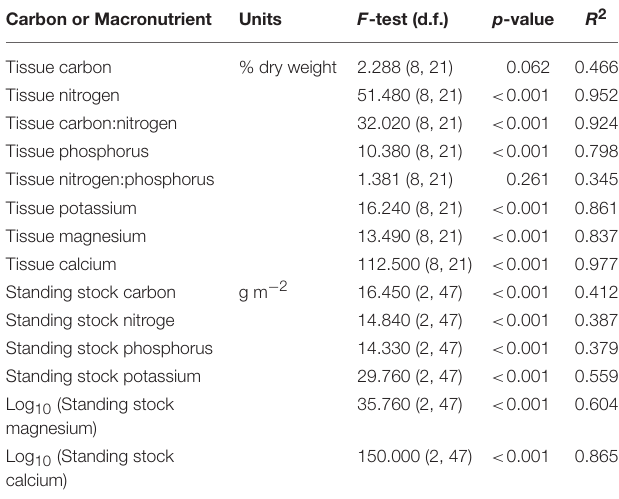
TABLE 6 | General linear model fit test results for carbon and macronutrients in plant tissue and estimated standing